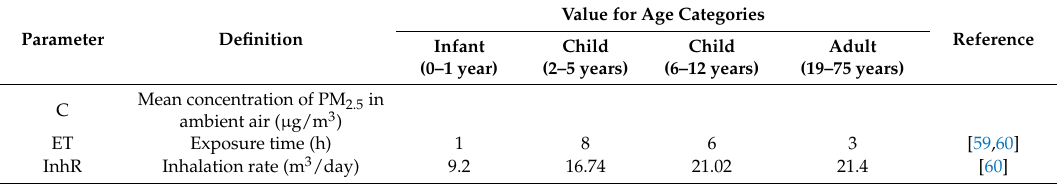
Table 1. Recommended values in equations of the daily exposure dose of PM